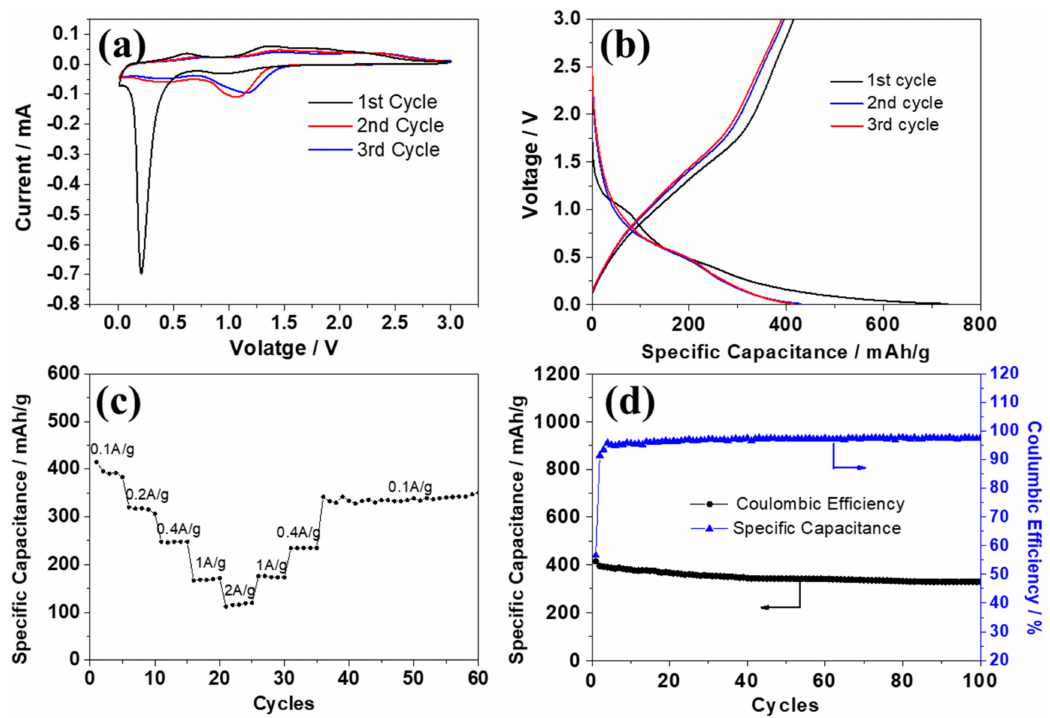
Figure 5. CV curves ( a ) and the first three discharge and charge curves ( b ) of the ZnCo 2 O 4 nanosheets; Rate ( c ) and cycle performance ( d ) of the ZnCo 2 O 4 nanosheets at the current density of 100 mA · g − 1 .